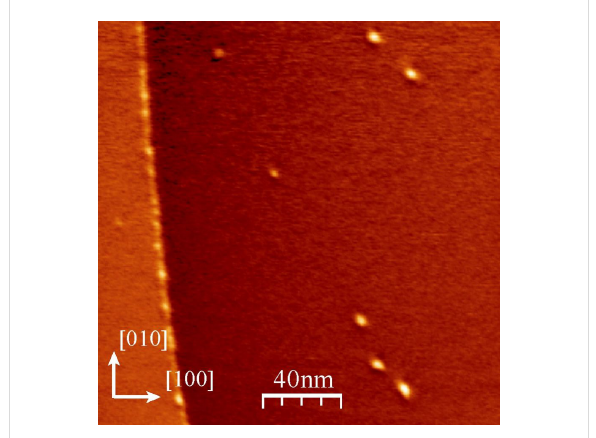
Figure 2: Constant-frequency-shift image of the KBr surface after the deposition of a small amount of molecules at room temperature. Imaging conditions: Δ f = − 5 Hz, oscillation amplitude A = 2 nm.